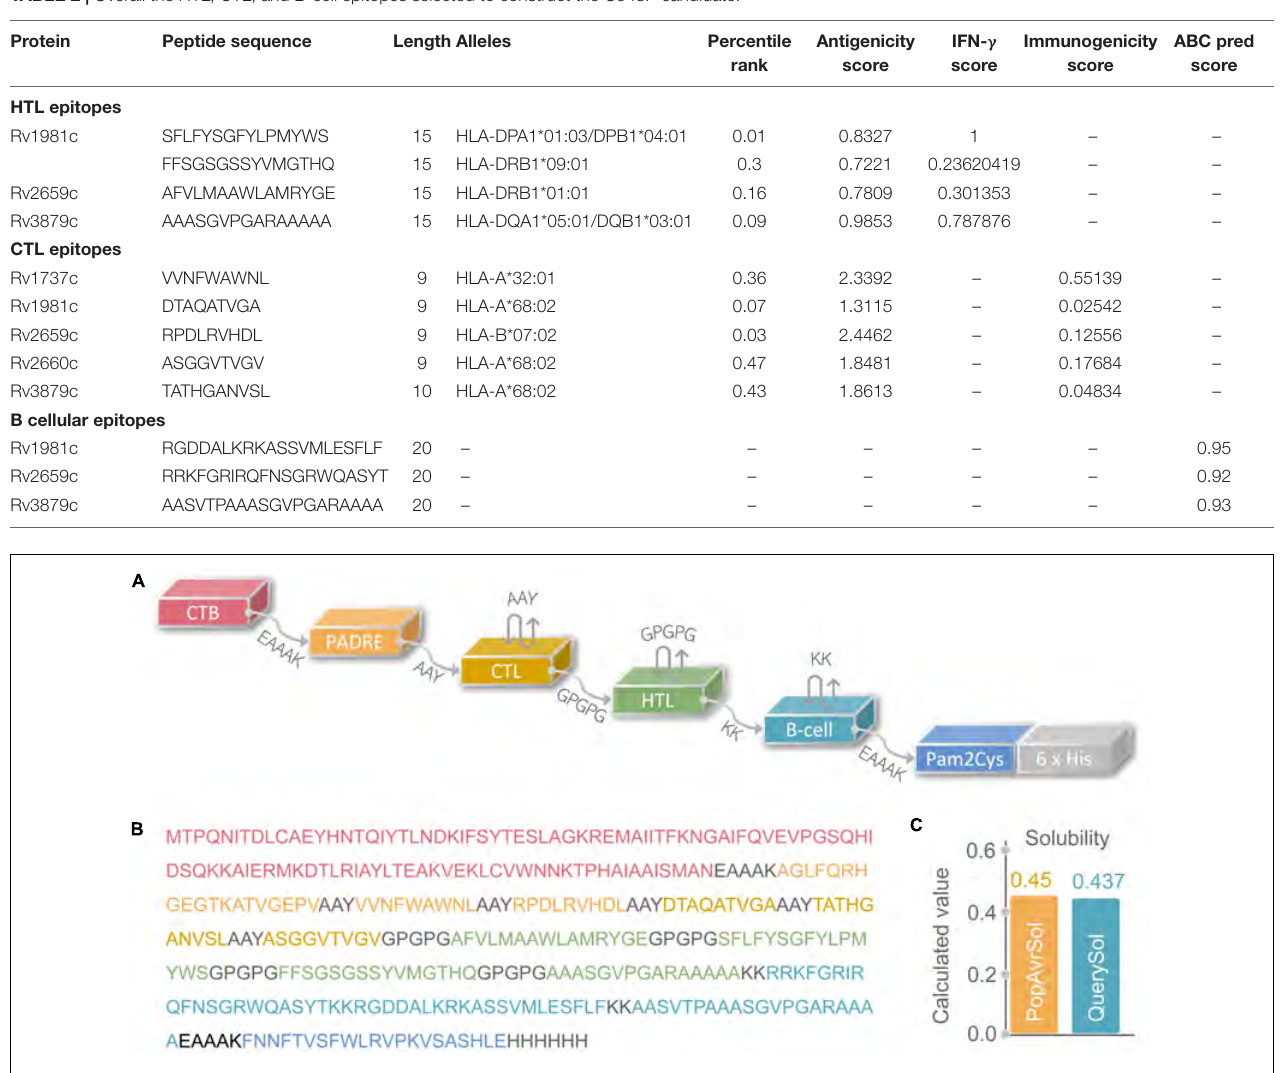
FIGURE 2 | (A) Schematic diagram of C543P polypeptide molecular construction. (B) Amino acid sequence. (C) Solubility analysis predicted by the Protein-Sol